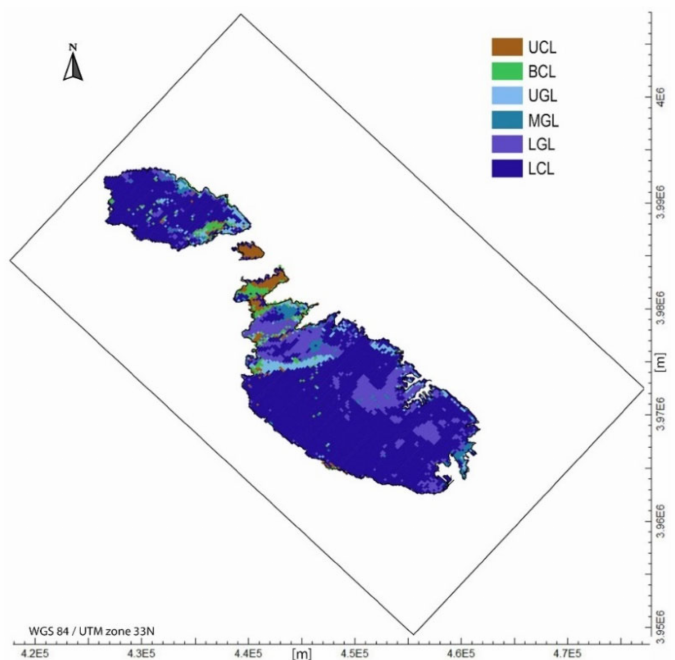
Figure 2. Spatial distribution of the geological formations between 0 and 5 m asl (uppermost layer of the model domain).